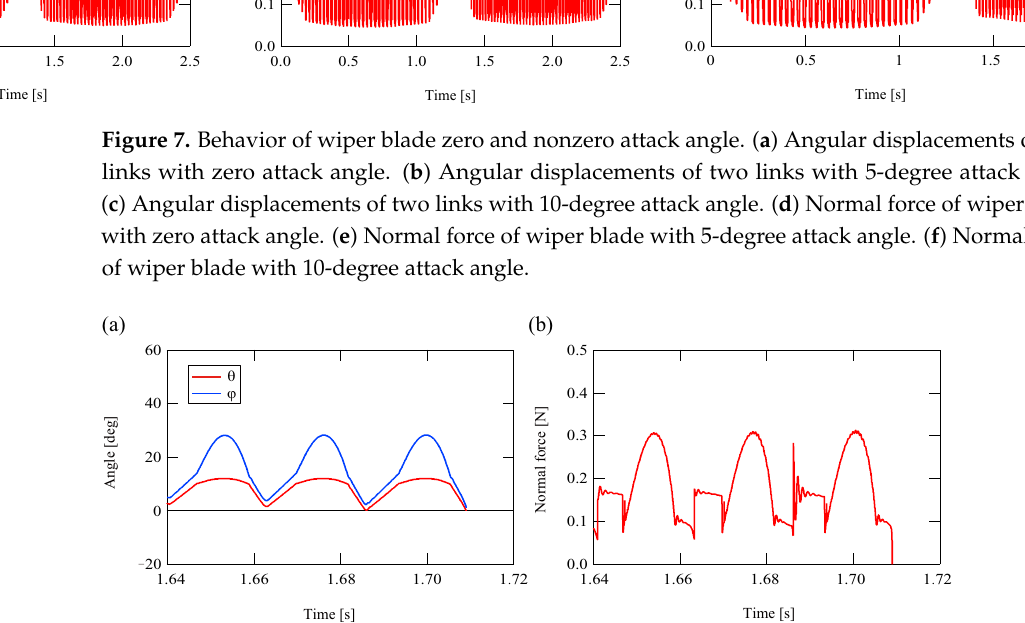
Figure 8. Enlarged view of Figure 7c,f from 1.64–1.72 s. Panels ( a ) and ( b ) correspond to Figure 7c,f,